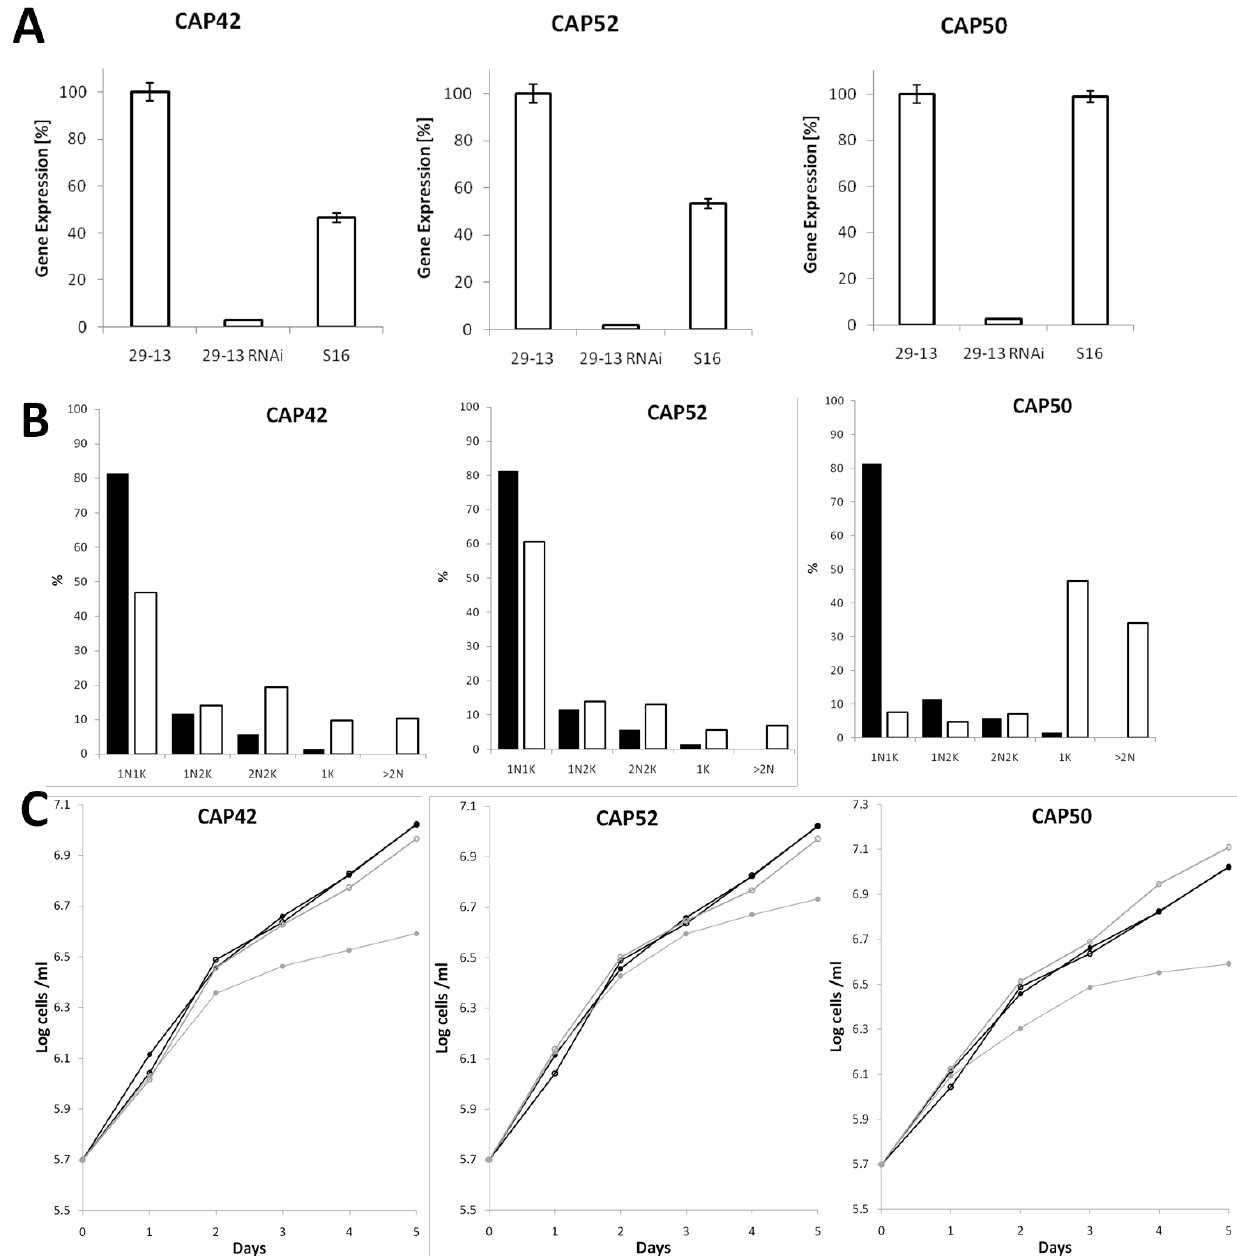
Figure 3. RNAi depletion of CAPs leads to reduced cell division and abnormal karyotypes in procyclic cells. ( A ) Relative mRNA expression levels of the three CAPs in procyclic (29-13), bloodstream (S16) and their respective RNAi cell lines (29-13 RNAi) measured by RT-qPCR. The RNAi cell lines were induced for 1 day. PFRA transcript was used for normalisation. ( B ) Analysis of cell cycle progression. Nuclei and kinetoplasts were visualised by DAPI staining. The number of nuclei (N) and kinetoplasts (K) was counted for each cell (n > 300). Black bars represent non-induced and white bars induced cells. Induction was for 3 days. ( C ) Cumulative cell growth of CAPs RNAi cell lines (grey lines, open circles: -tet; grey lines, closed circles: +tet) compared to wild type cells (black lines, open circles: -tet; black lines, closed circles: +tet). Growth curve data are averages of three independent clones.